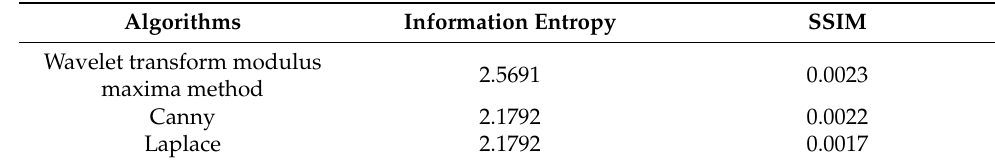
Table 1. Information entropy and SSIM for the three